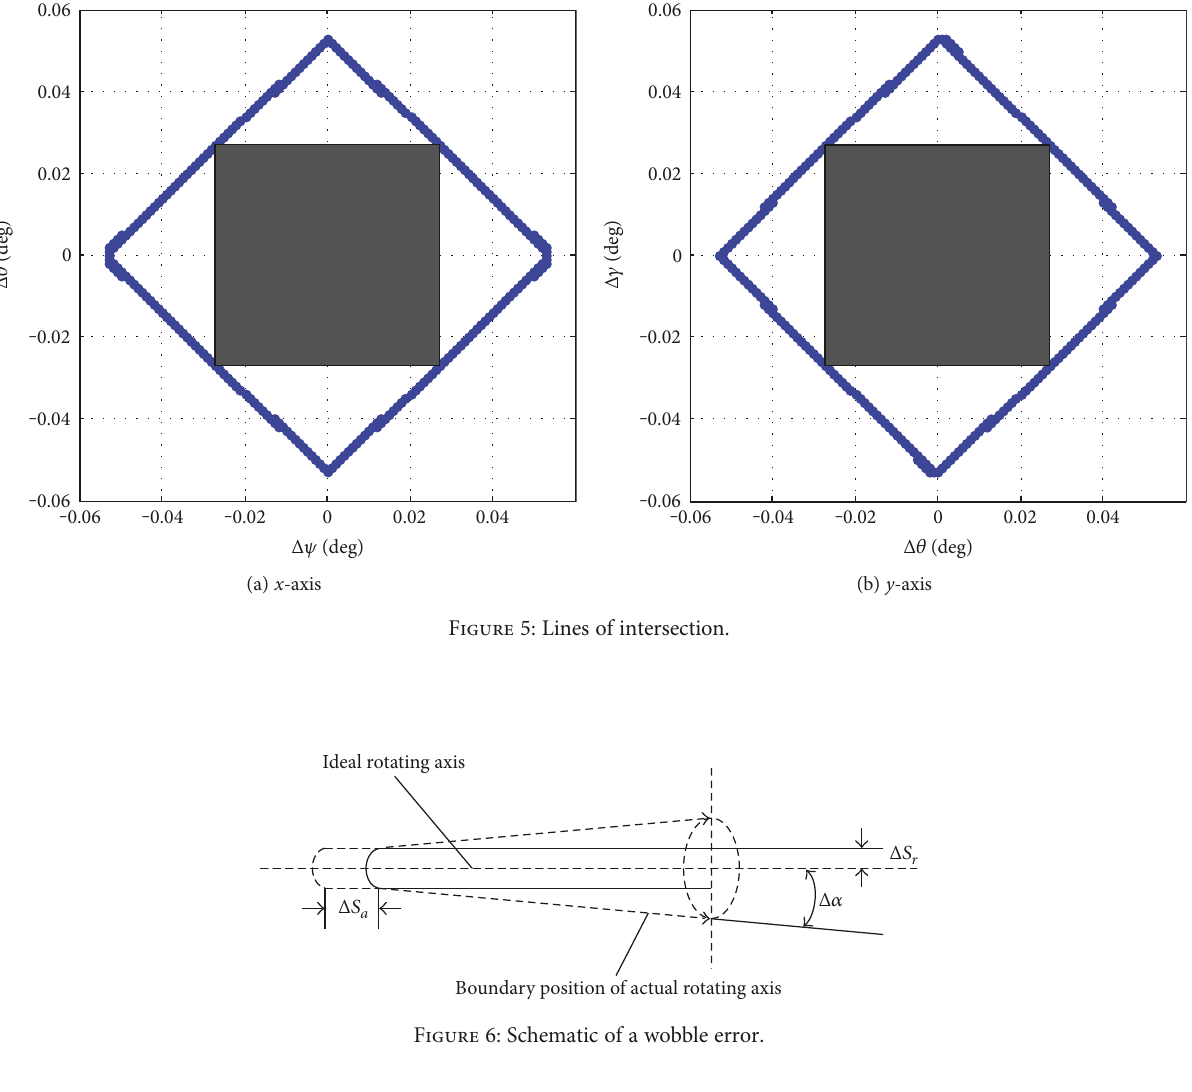
Figure 6: Schematic of a wobble error.